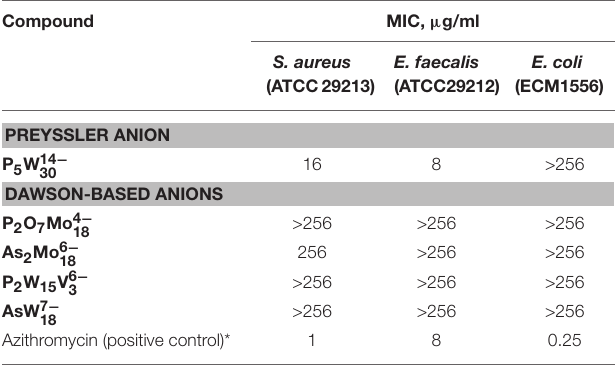
TABLE 2 | Minimum inhibitory concentration (MIC) of Dawson and Preyssler type POMs against the M. catarrhalis strains. Compound MIC, µ g/ml